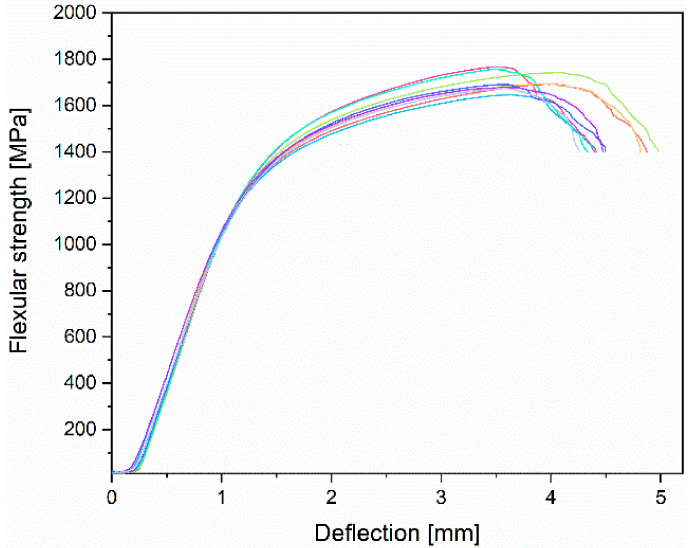
Figure 10. Experimental strength–deflection curves obtained from the three-point bending test for Ti-13Nb-13Zr alloy samples.